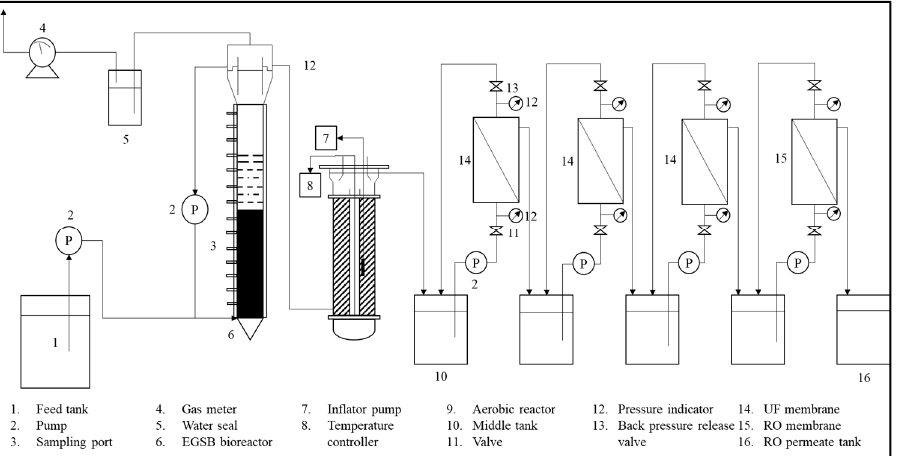
Figure 12. Schematic diagram of integration treatment for POME. Adapted with permission from ref. [60]. Copyright 2008 Elsevier. Table 3. Summary of alternative POME treatment methods including COD removal efficiency, advantages, and disad- vantages.